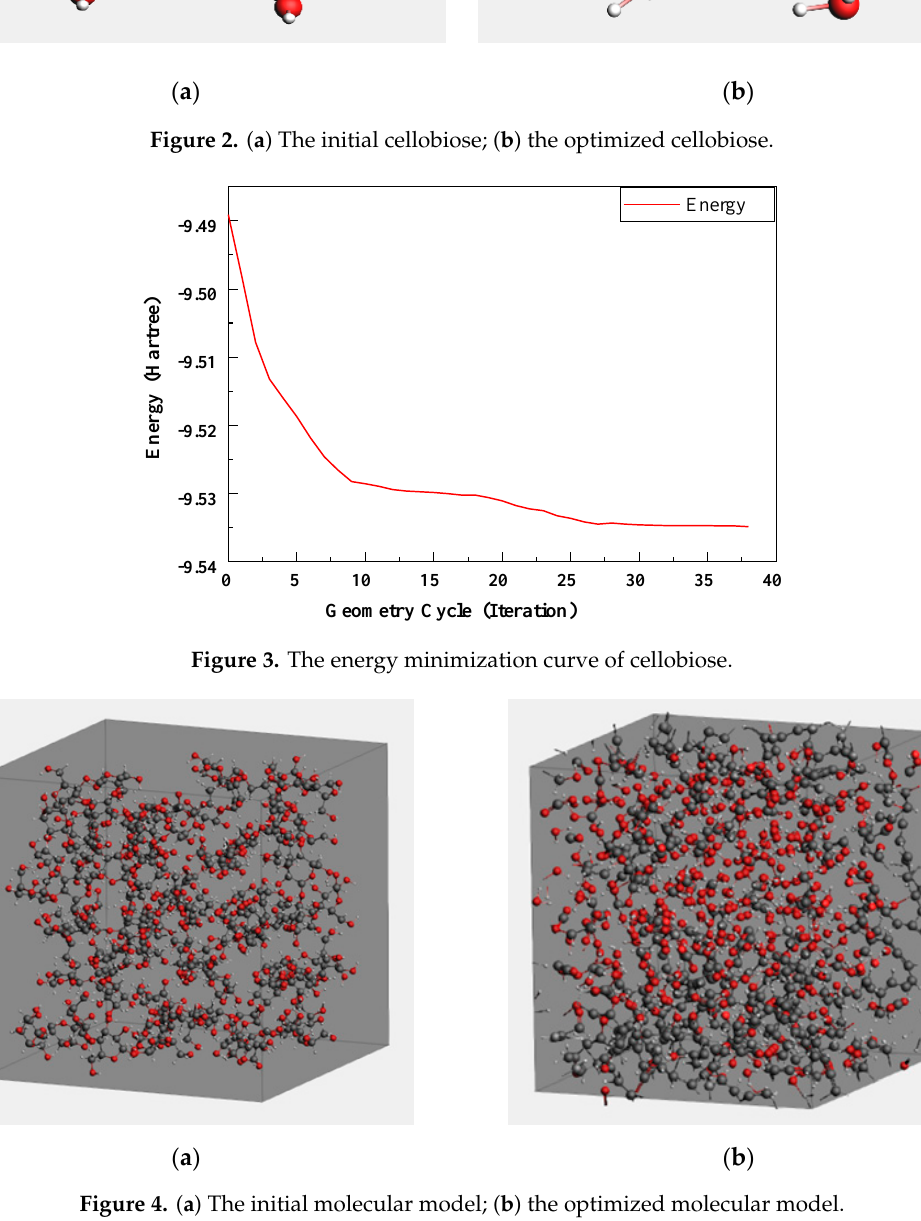
Figure 4. ( a ) The initial molecular model; ( b ) the optimized molecular model.